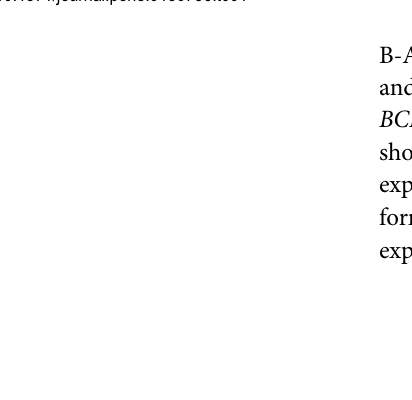
B-ALL patients (76) (Table 1) expressed other Ikaros isoforms (Ik1, Ik3A, Ik2, Ik4, Ik5, Ik7, and Ik4A), 17 of them presented gene fusions as follows: ETV6-RUNX1 (10), E2A-PBX1 (4), BCR-ABL1 (2) and AF9-MLL (1). Patients with T-ALL only expressed Ik8 (3/14) and none showed gene fusions. Of the 113 patients studied, 23% expressed Ik6 and/or Ik8 and 77% expressed one or more of the other isoforms already reported for Ikaros. Ik1, Ik3A and Ik2 iso- forms were predominantly expressed in our patients; Ik4, Ik4A, Ik5 and Ik7 were also expressed although in lower proportion (Table 1).